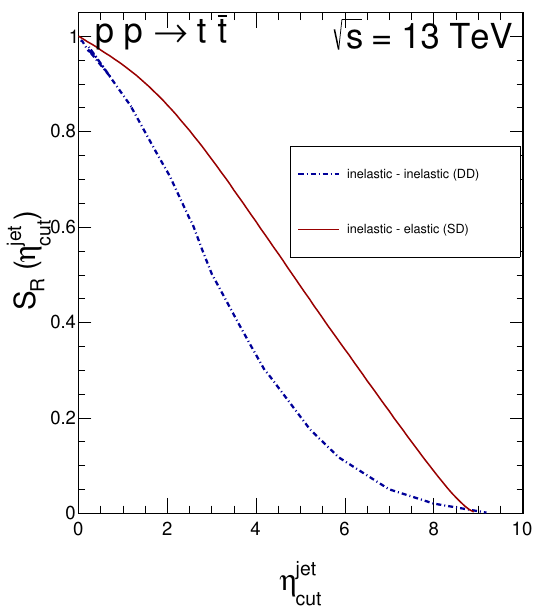
Figure 12 . Gap survival factor for single and double dissociation as a function of the size of the pseudorapidity veto applied on the recoiling jet emitted from proton